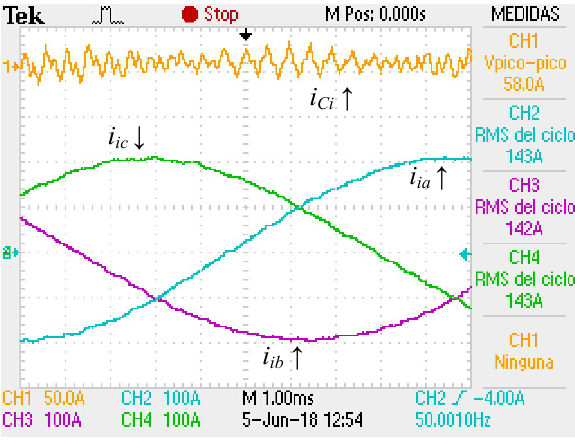
Figure 21. Input current at the PCC i .